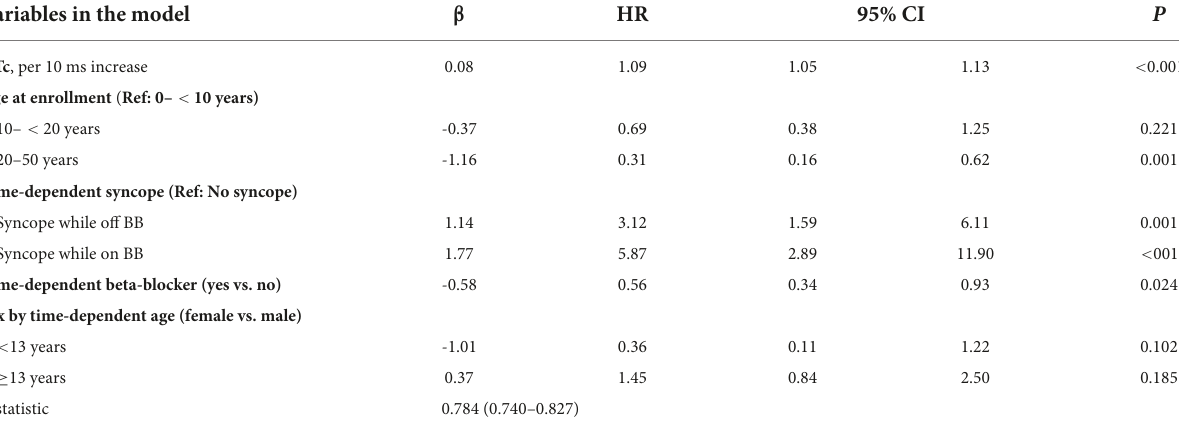
TABLE 2 Model predicting ACA, SCD, or appropriate ICD shock after enrollment in 1,509 LQTS patients with QTc ≥ 470 ms (No. of events = 77, 30 SCD, 14 ACA, and 33 shock).